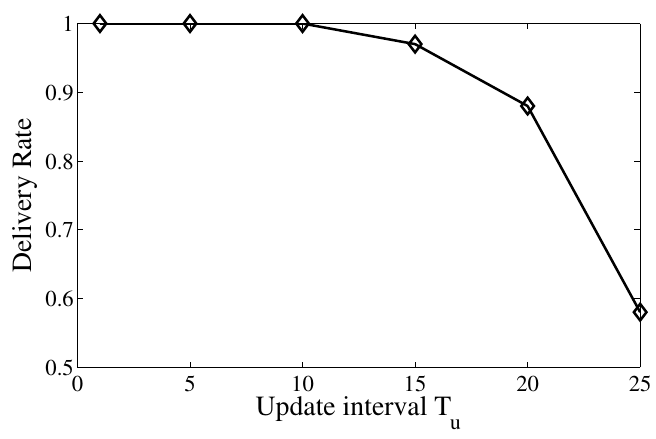
Figure 6. Delivery rate of TS with different footprint update